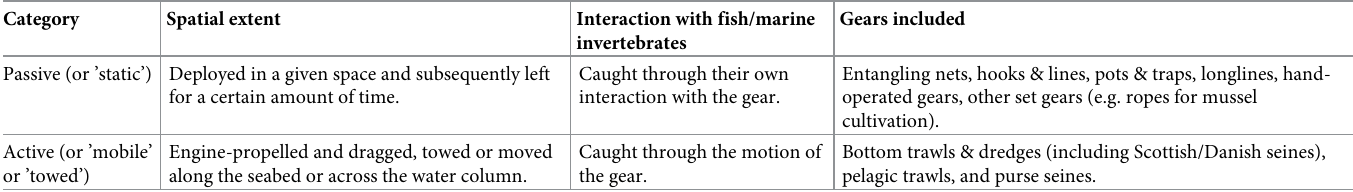
Table 2. Characteristics of ’passive’ vs. ’active’ gears.